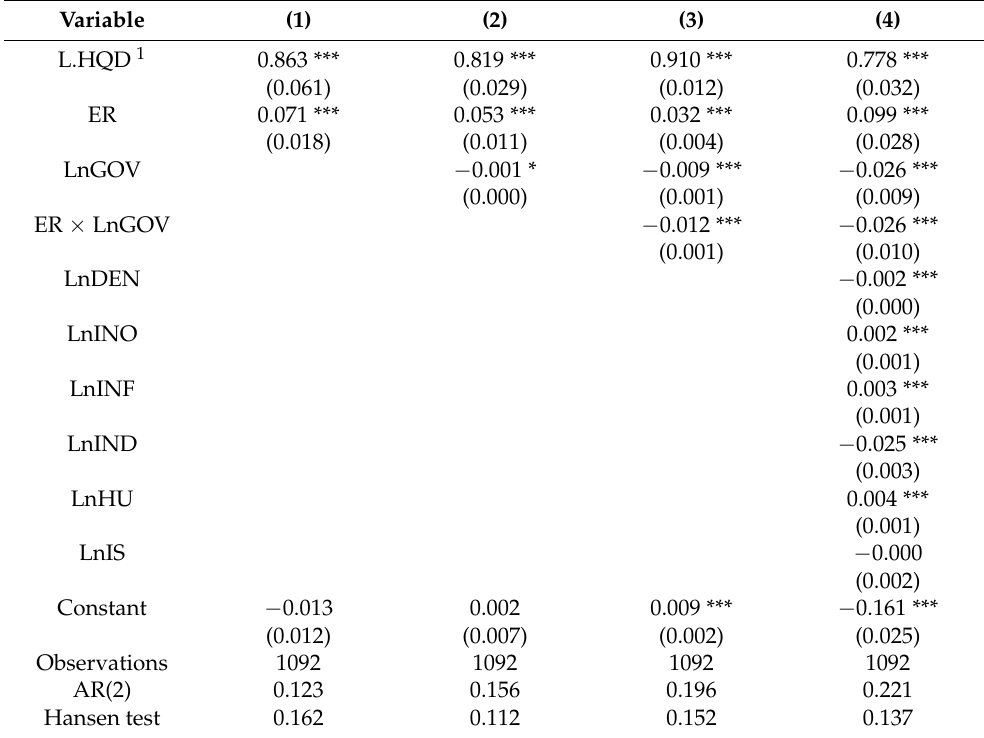
Table 7. Robustness test results: endogenous